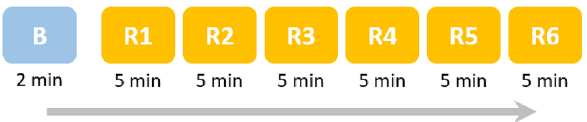
Figure 2. Flow diagram of neurofeedback training in a single visit. B = Baseline before the neurofeedback training. R1… R6 = First neurofeedback training run… sixth neurofeedback training